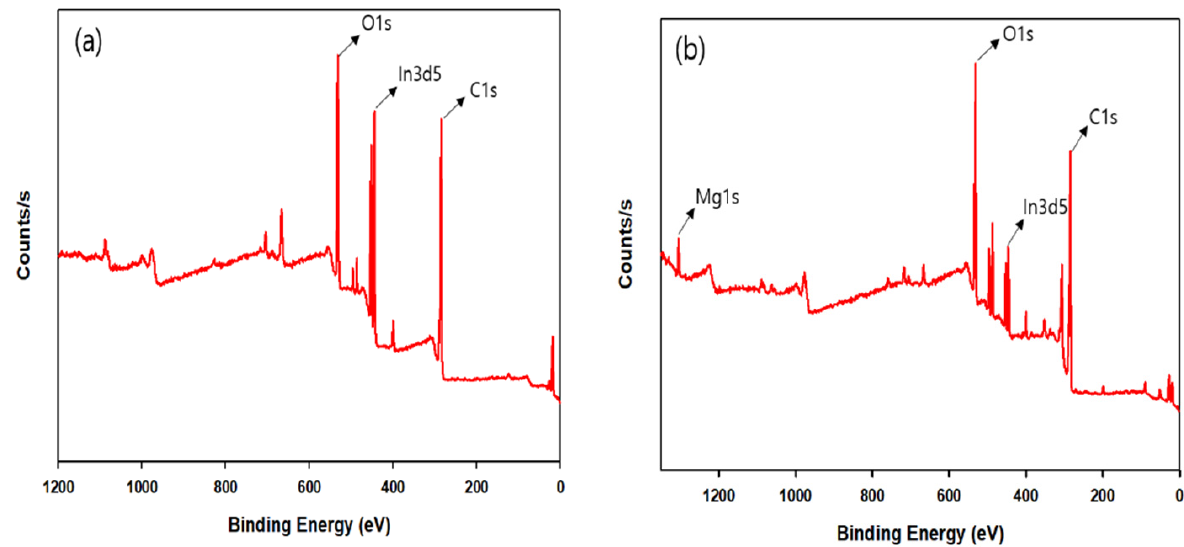
Figure 5. XPS spectrum of ( a ) CPM-200-In and ( b ) CPM-200-In/Mg.